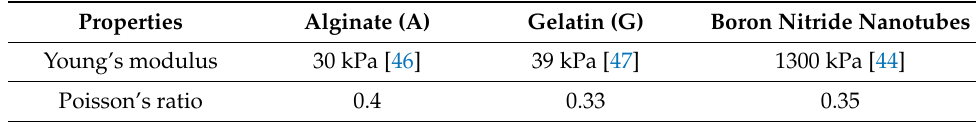
Table 1. Properties of raw